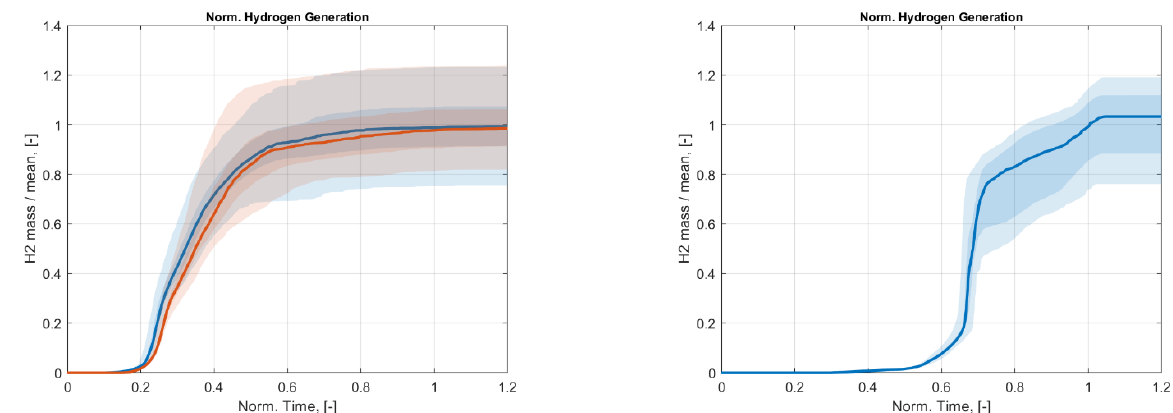
Figure 10. Comparison of FoM, normalized by the mean value at the end of calculations. The time normalized by the value of the estimated oxidation phase time, in relation to the beginning of the transient. All data were processed, interpolated, and extrapolated for successful and partially successful data. The solid line presents the median value, and the dark shaded region is the 50% quartile; the light shaded region represents the 95% percentile. ( Left )—PWR reactor; blue is the PWR top peak case, and red is the PWR with the FPT-like power profile. ( Right )—blue FPT-1.